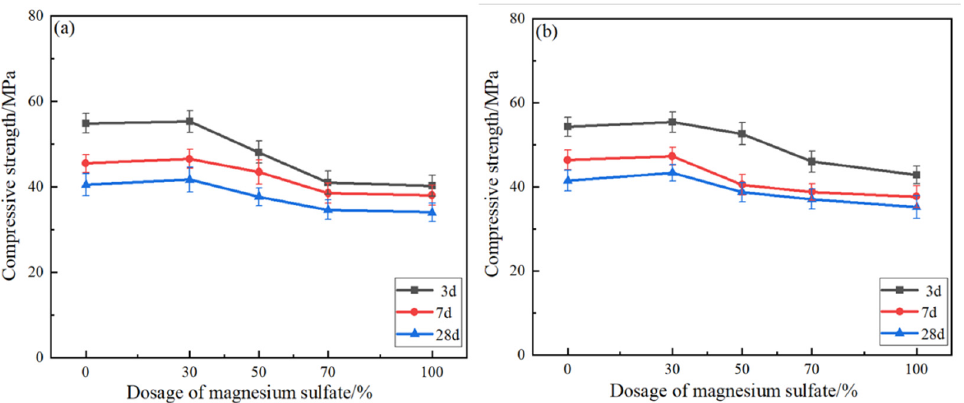
Figure 3. The compressive strength of MOC with different mass fractions of MgSO 4 after water im- mersion ( a ): 6:1:15; ( b ): 7:1:18.